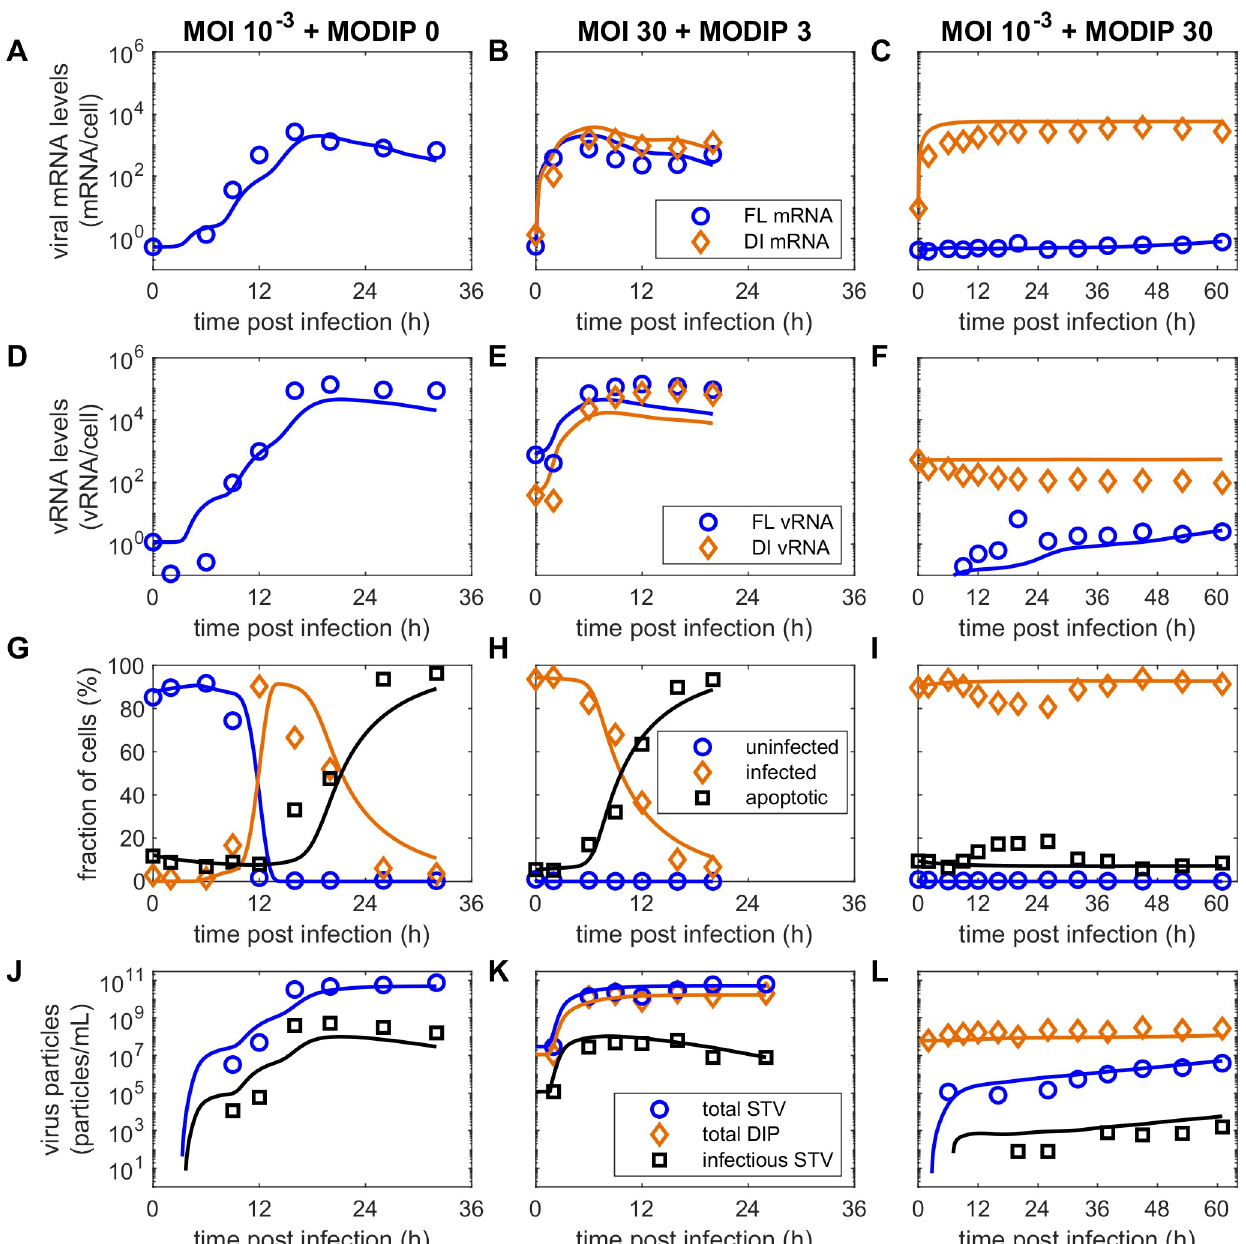
Fig 5. The extended multiscale model captures infection dynamics on the intracellular and cell population level for all measured infection conditions. Curves depict simulations of the extended model fitted to (A-C) cell-specific viral mRNA, (D-F) cell-specific vRNA, (G-I) cell population and (J-L) extracellular virus titers measured in MDCKsus cell cultures infected with different amounts of influenza A/PR/8/34 (H1N1) and defective interfering particles (DI244). Results for MOI 10 − 3 and MODIP 0 (first column), 30 and 3 (second column), and 10 − 3 and 30 (third column) are shown. The figures presenting cell population dynamics (G-I) show fits to uninfected non-apoptotic, infected non-apoptotic, as well as the sum of uninfected and infected apoptotic cells. The extended model is based on Ru¨diger et al. [27] and Laske et al. [23], but additionally considers primary transcription of viral mRNA, segment-specific viral mRNA production, a reduced vRNA synthesis for high MODIP conditions and a DIP-induced reduction of cell growth. Simulation results for all other infection conditions are shown in S3–S10 Figs.